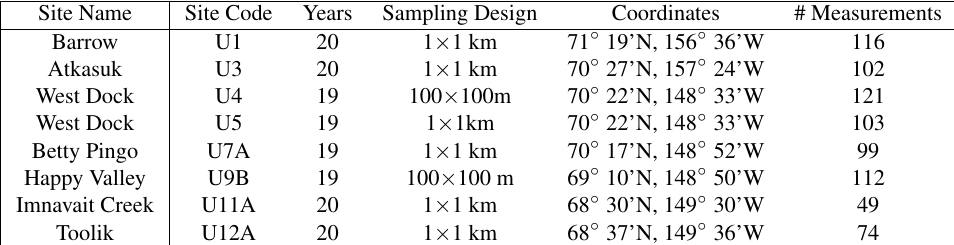
Table 1. Site Locations and Features